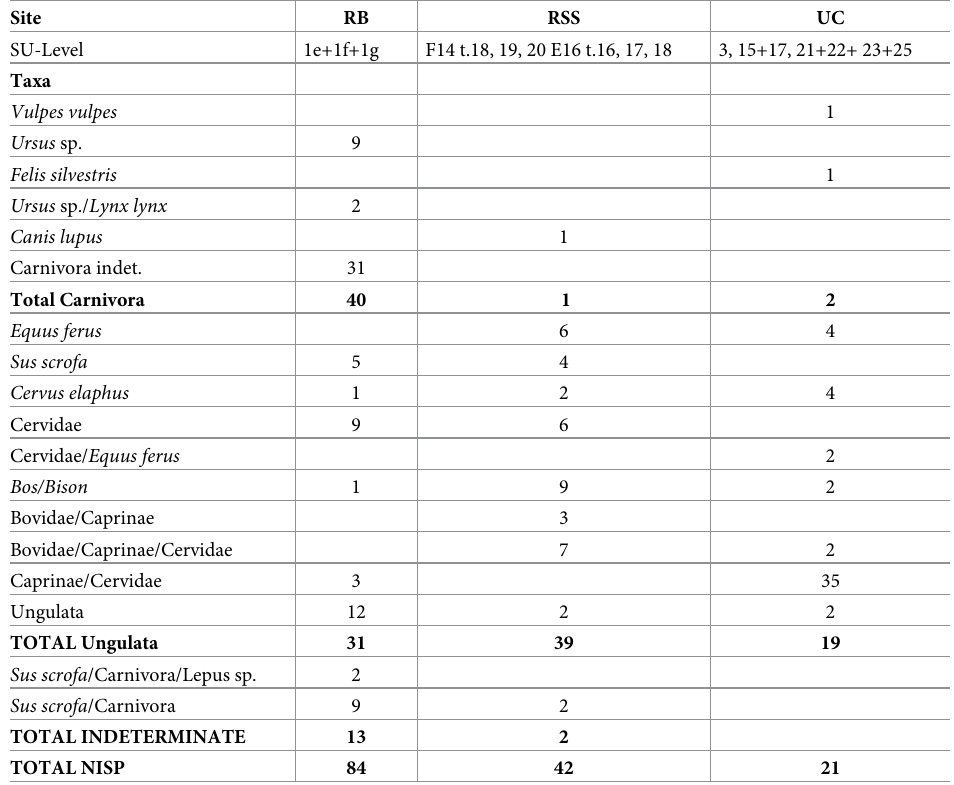
Table 2. ZooMS taxonomic determination for the three analysed contexts. RB (Riparo del Broion), RSS (Roccia San Sebastiano cave), UC (Uluzzo C Rock Shelter).